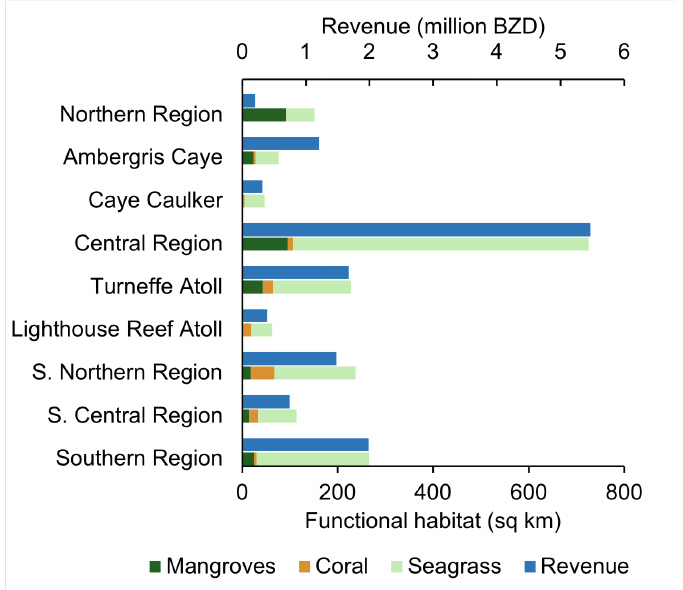
Figure A1.3 Modeled lobster revenue and area of each habitat type in Belize by planning region in 2010, the Current scenario.